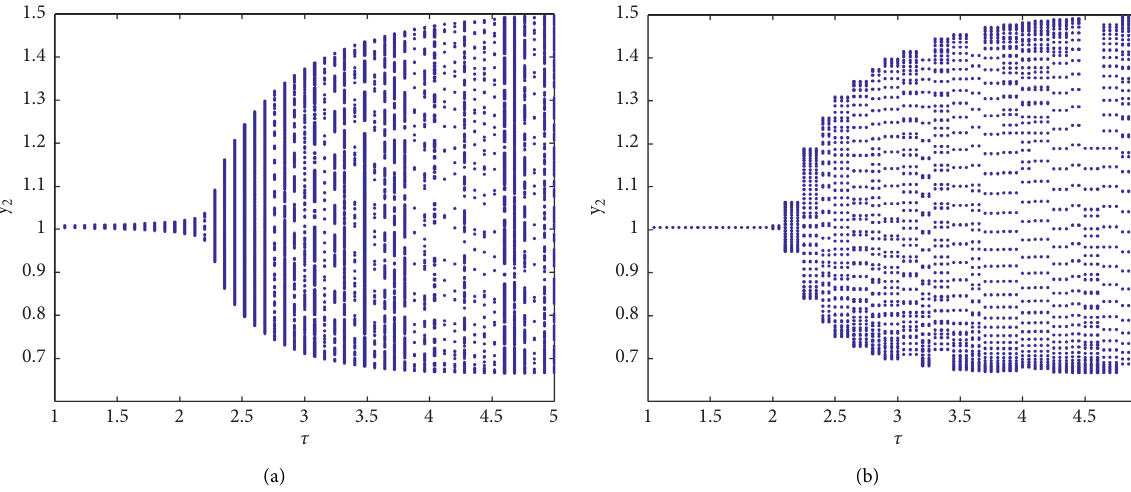
Figure 10: The bifurcation diagram of the system for y